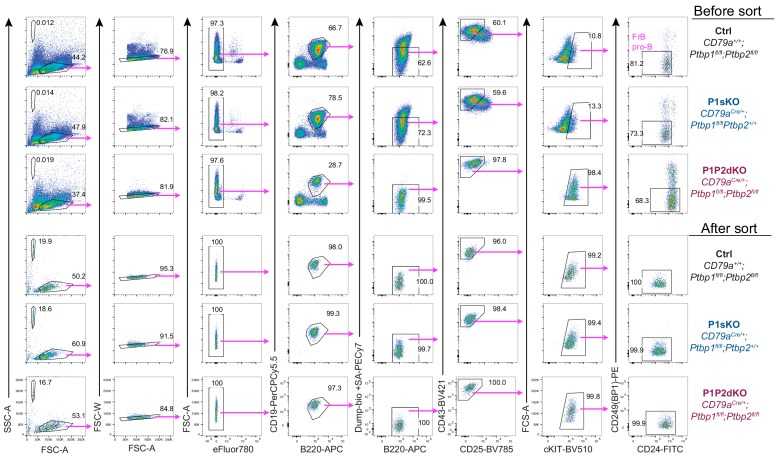
Cell sorting strategy of pro-B cells.Cell sorting strategy of FrB pro-B (B220+CD19+IgM-IgD-CD2-CD43highCD25-cKIT+CD24+CD249+) cells used to isolate RNA and carry out mRNAseq libraries. ‘Dump’ contains excluded cells stained with anti-IgM, anti-CD2 and streptavidin. Prior sorting, bone marrow cells were depleted from Gr-1, CD11b, IgD, NK1.1, CD3e and Ter119-positive cells using biotinylated antibodies.